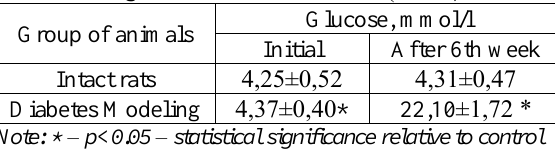
Blood glucose content in serum. (M±m, n=7) Group of